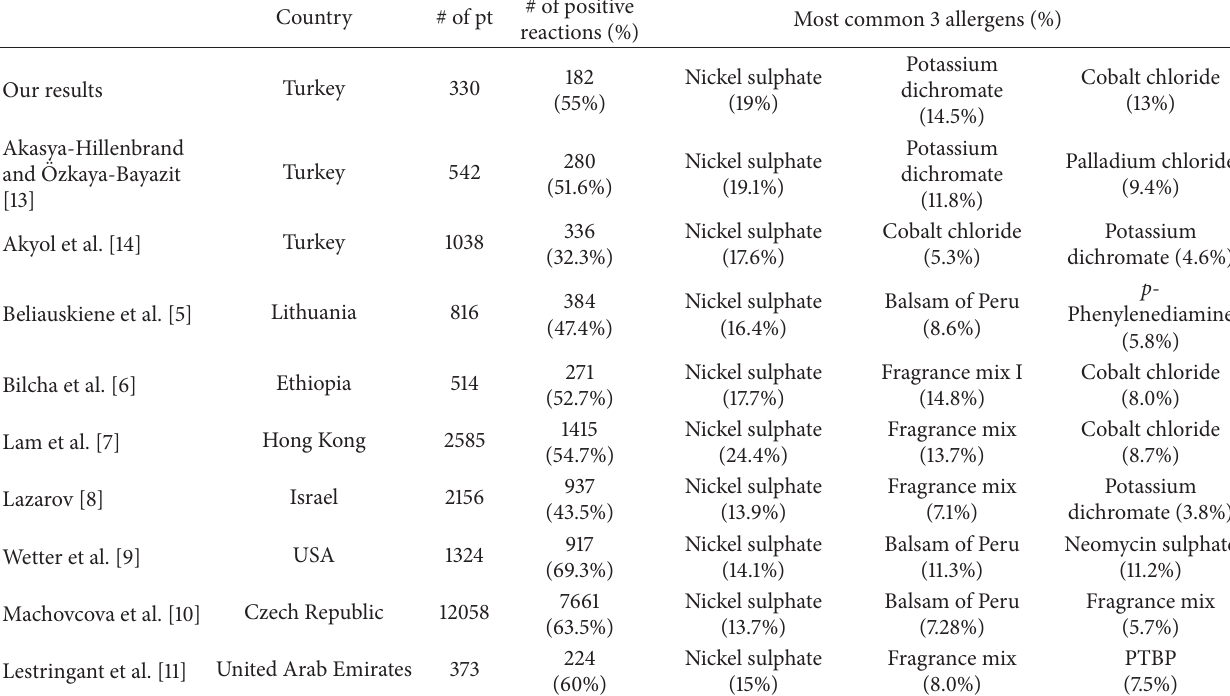
Table 3: Most common allergens in previous